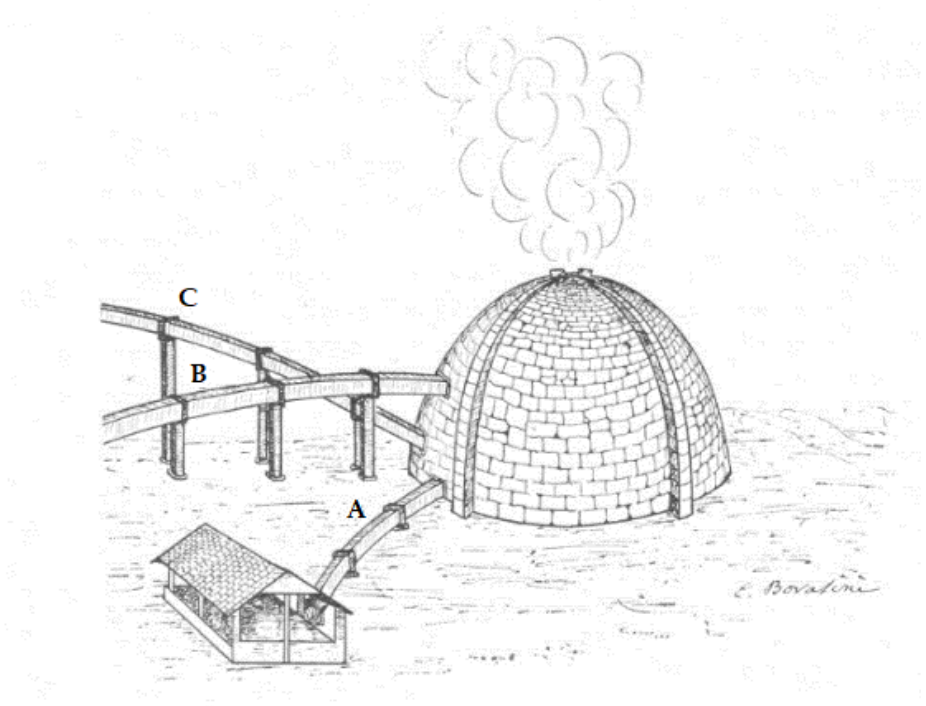
Figure 6. The ‘lagone coperto’ (covered lake) used to collect steam and hot waters containing boric acid. (A) boric water exit; (B) steam exit; (C) hot water inlet.